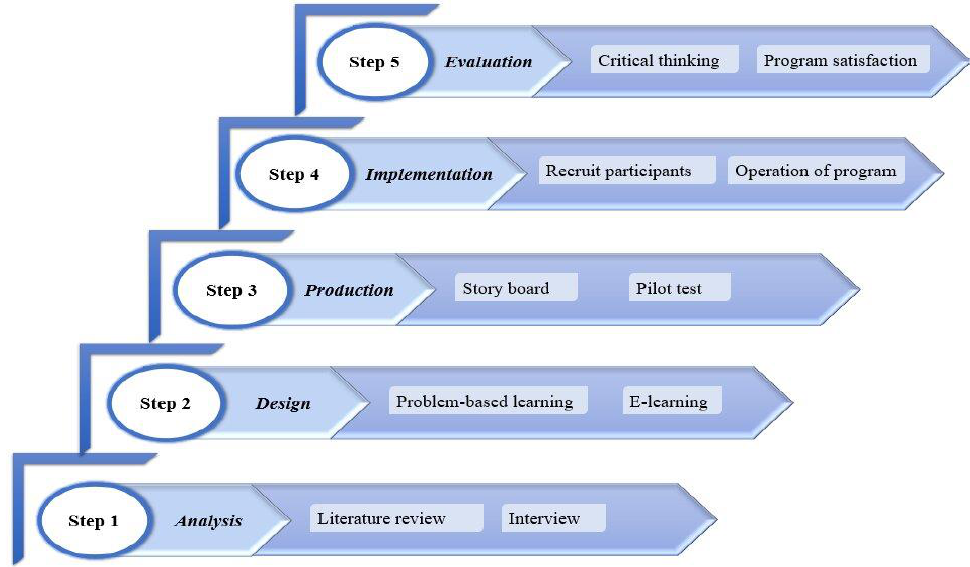
Figure 1. Developmental process of the educational program.